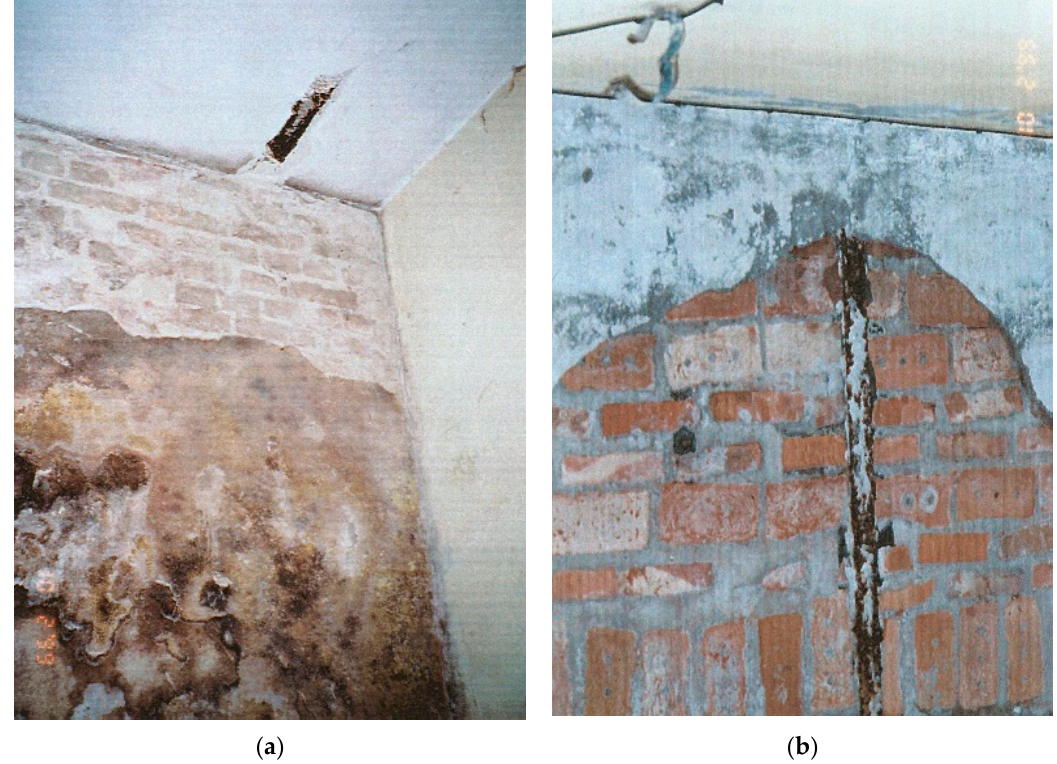
Figure 9. Willa Halina, view of degraded structural elements. ( a ) Mold on the outside wall; ( b ) moisture and corrosion of internal wall elements. Source: FORT Taraszkiewicz Architekci.